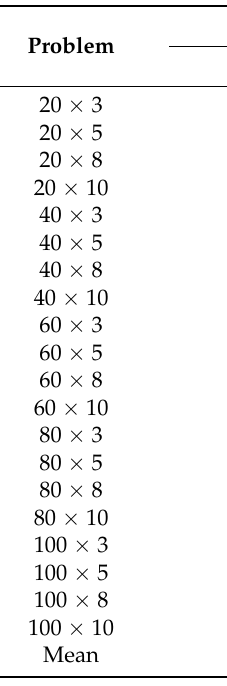
Table A3. IGD -metric for search strategy.